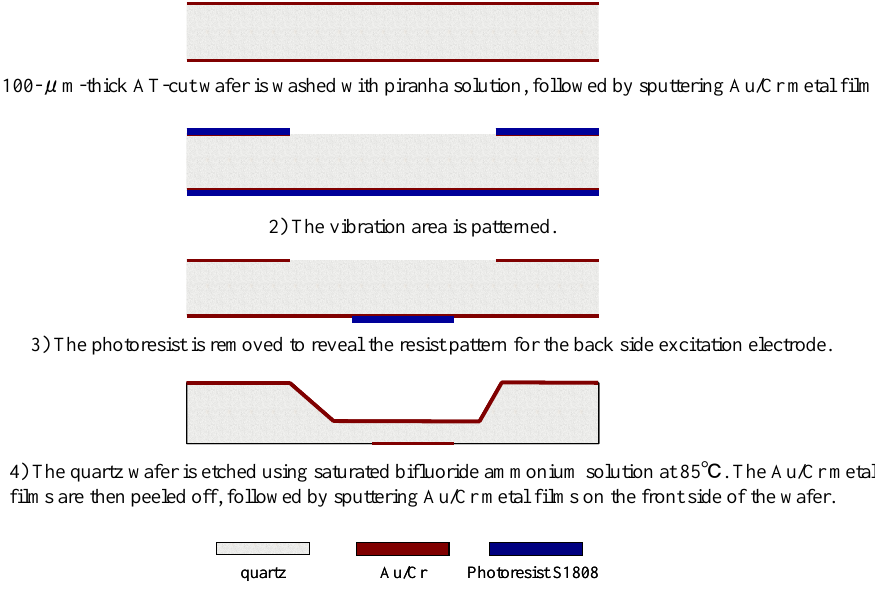
Figure 2. Fabrication process flow of a quartz resonator.